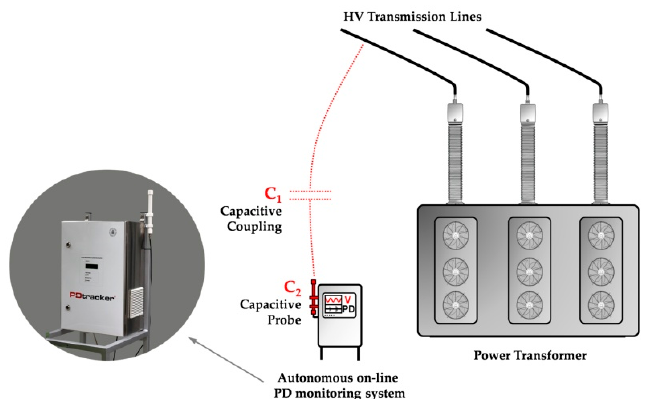
Figure 3. Schematic diagram of non-contact high voltage measurement with the use of a capacitive probe for an autonomous online partial discharge monitoring